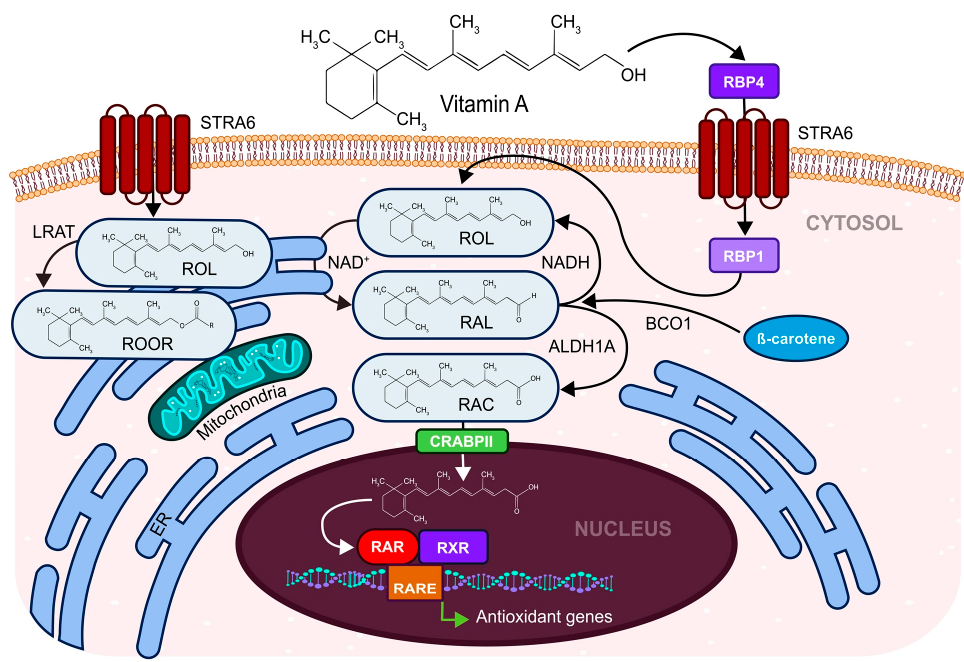
Figure 3. Vitamin A (retinol) activity in response to oxidative stress. Vitamin A is carried on RBP4 (Retinol Bindin Protein 4) protein and is translocated to the cell cytosol via its integral receptor STAR6 (Stimulated by Retinoic Acid 6 Receptor). In the cytosol, vitamin A is carried on RBP1 (Retinol Binding Protein 1). Vitamin A (retinol, ROL) undergoes oxidation on the endoplasmatic reticulum (ER) to form RAL (retinal) and, via catalytic activity of ALDH1A (aldehyde dehydrogenase member A1 or retinaldehyde dehydrogenase 1), to form RAC (retinoic acid). The β -carotene can also be converted into RAL by β -carotene 15–15 ′ -oxygenase. RAC enters the nucleus and binds to regulative elements on the DNA and affects the target antioxidant gene transcription. ROL can be converted via the catalytic activity of LRAT (Lecithin Retinol Acyltransferase) to its esters (ROOR) as well.